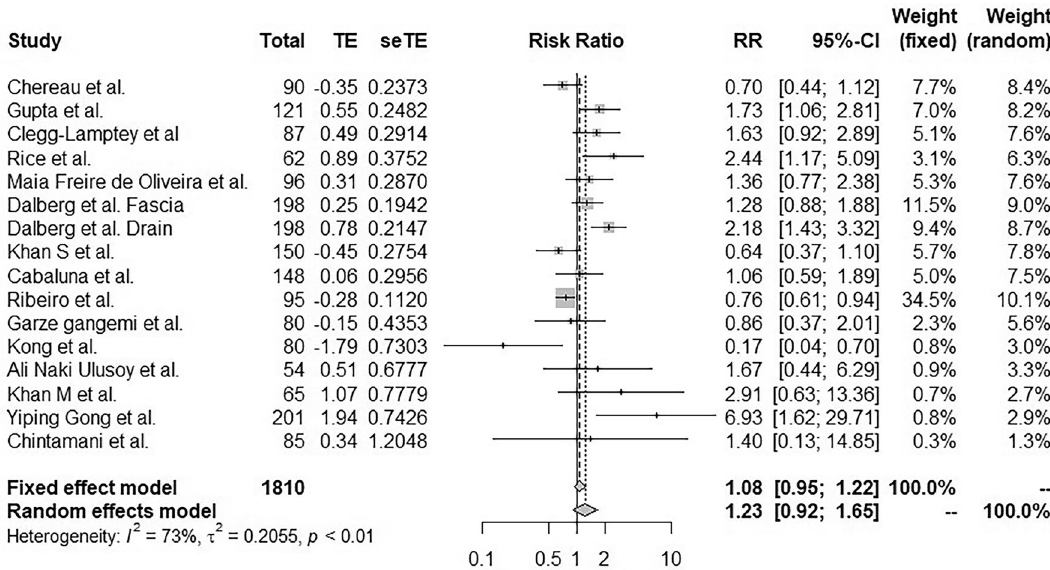
Figure 2. Forest plot for seroma incidence following application of a treatment designed to prevent lymphocele after mastectomy with axillary lymphadenectomy. Risk ratios are shown with 95% confidence